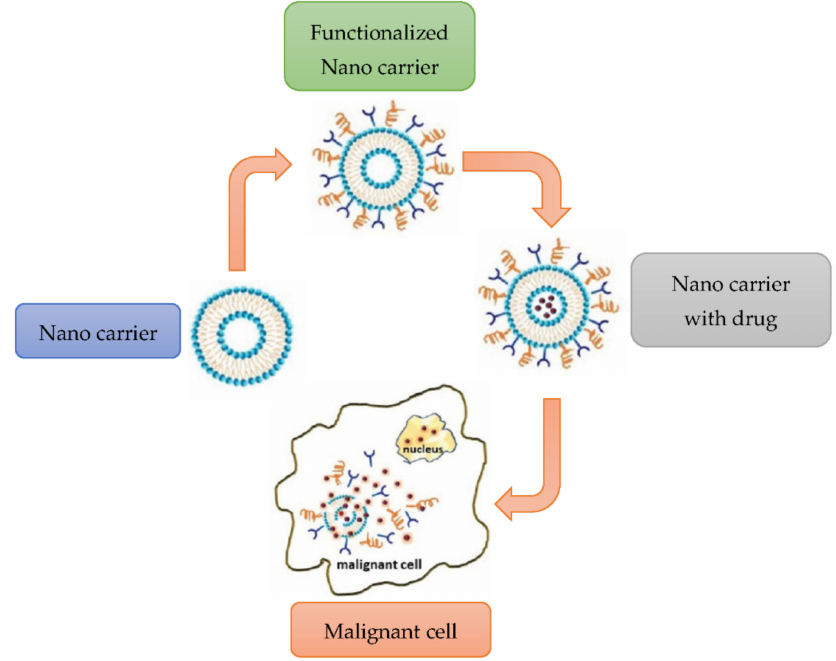
Figure 28. Process of drug delivery. Modified from